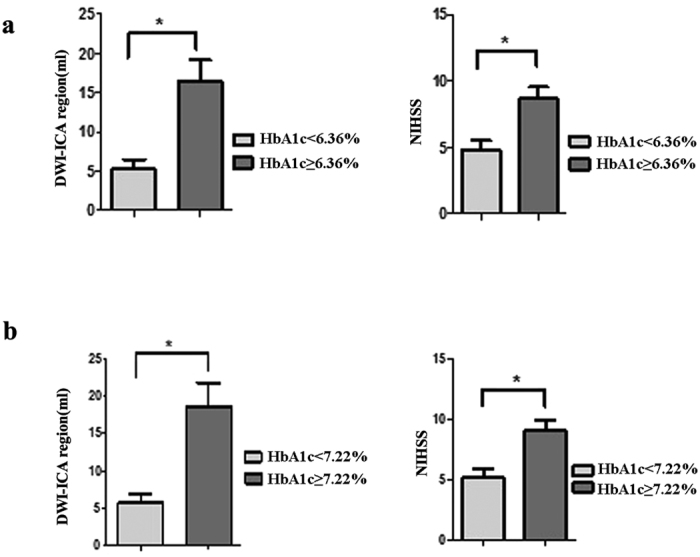
DWI hyperintensity volume in ICA region (DWI-ICA region) and National Institutes of Health Stroke Scale (NIHSS) score between different HbA1c groups.(a) HbA1c < 6.36% and HbA1c ≥ 6.36% group; (b) HbA1c < 7.22% and HbA1c ≥ 7.22% group. *p < 0.05.